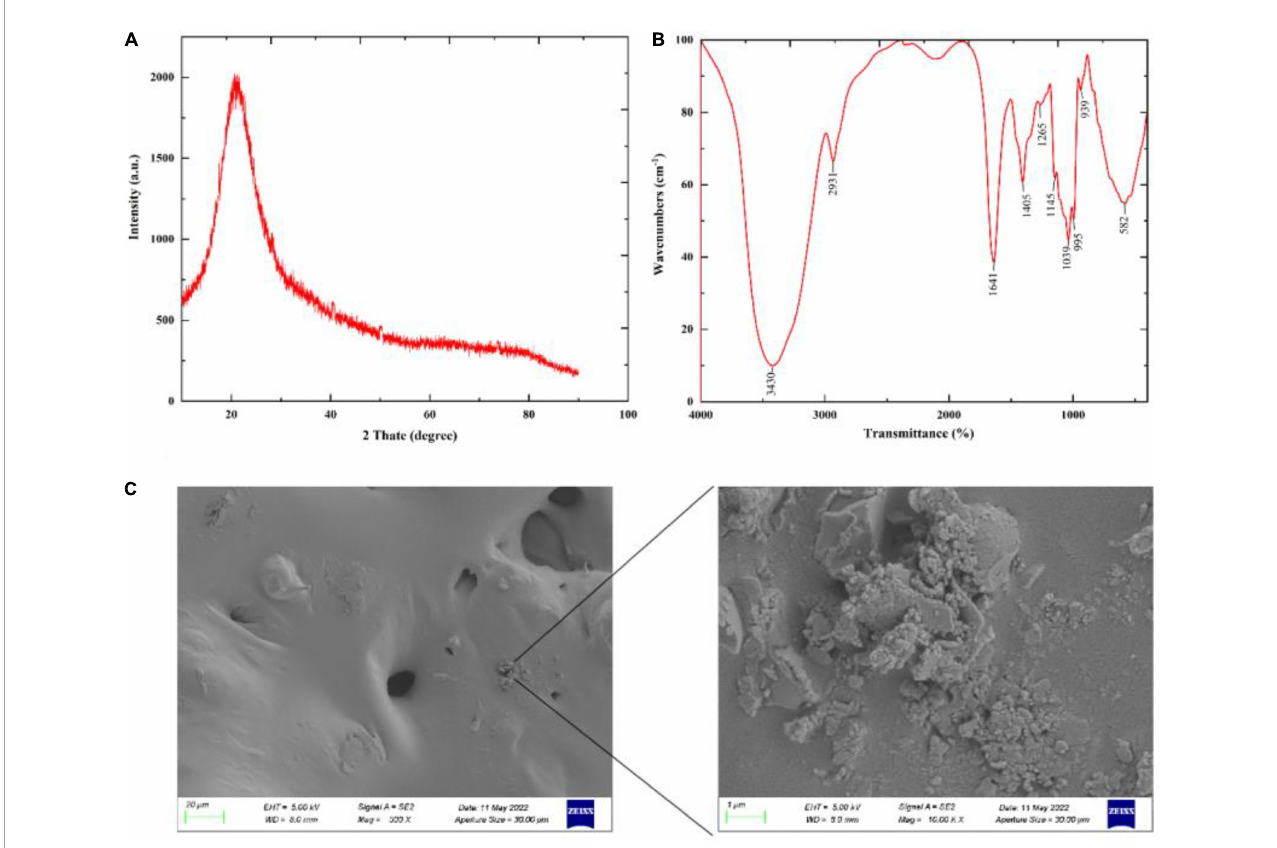
FIGURE5 Partial structural analysis of GFP: (A) XRD scan result of GFP; (B) FTIR detection result of GFP; and (C) SEM detection result of